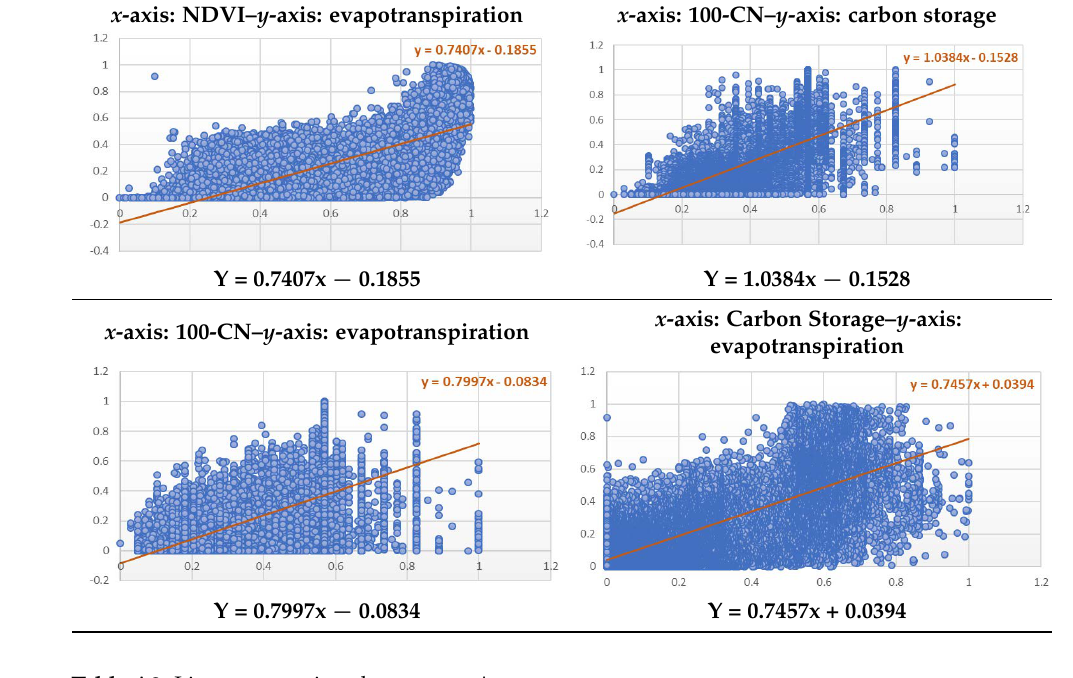
Table A2. Linear regression slopes: type